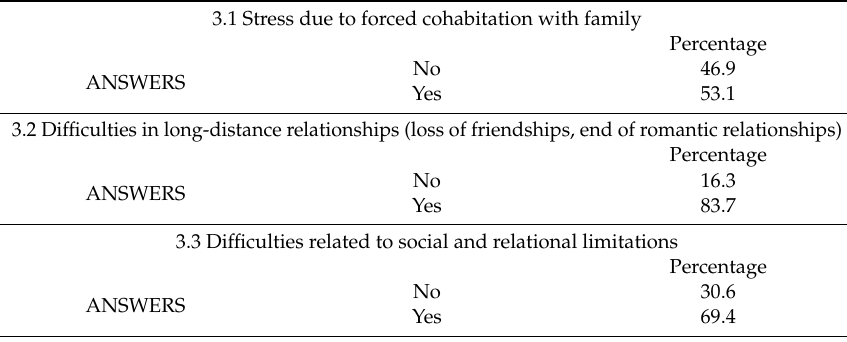
Table 3. Area 3: family and social relations.